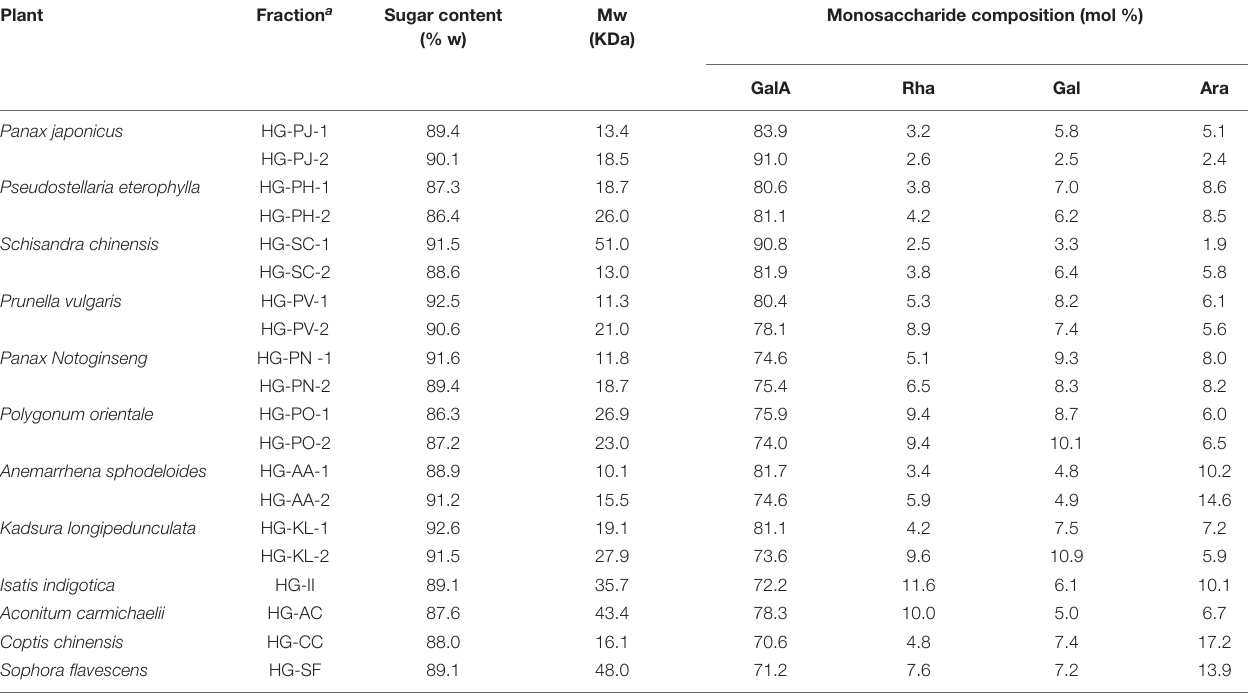
TABLE 1 | Basic physicochemical properties of twenty kinds of homogalacturonan (HG) pectin.